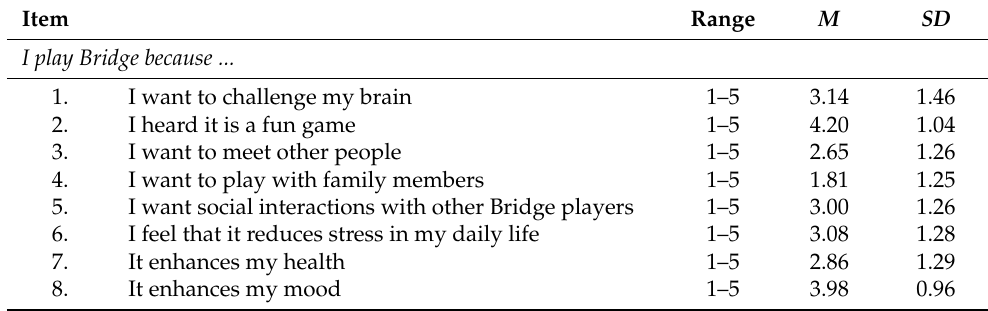
Table 2. Ranges, means and standard deviations of the bridge motivational factors checklist.